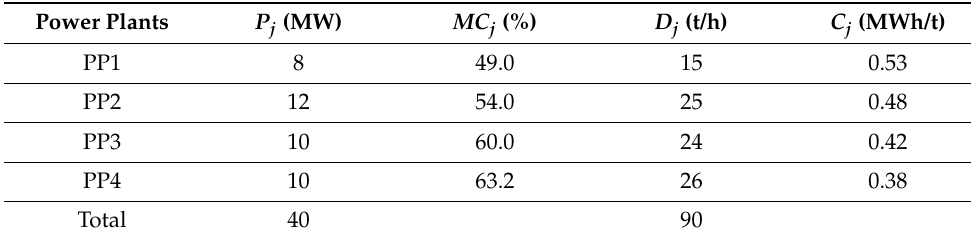
Table 4. Data for power plants in Example 2.